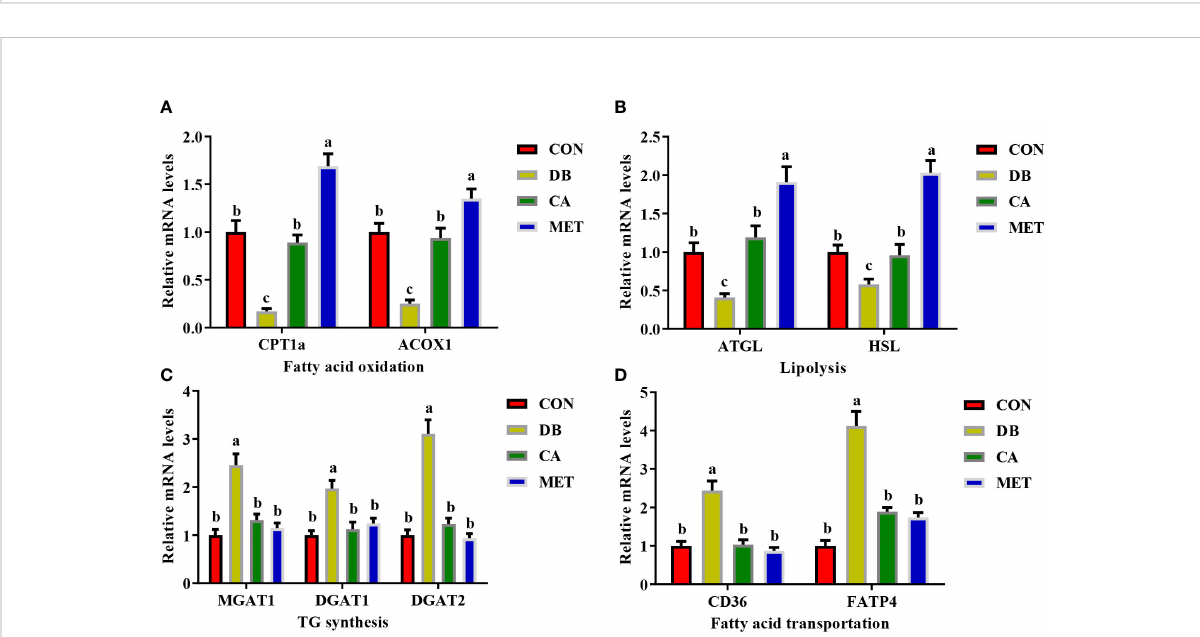
FIGURE 3 Effects of chlorogenic acid on the expression of genes involved in lipid metabolism in the livers of diabetic db/db mice. (A) Expression of genes involved in fatty acid oxidation; (B) Expression of genes involved in lipolysis; (C) Expression of genes involved in TG synthesis; (D) Expression of genes involved in fatty acid transportation. Data are expressed as the means ± SEMs, n=6. a,b,c Groups that share the same superscript letters are not signi fi cantly different from each other ( P <